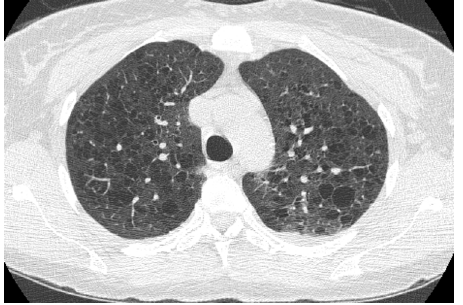
Figure 2. Selected CT image showing emphysema in HIV